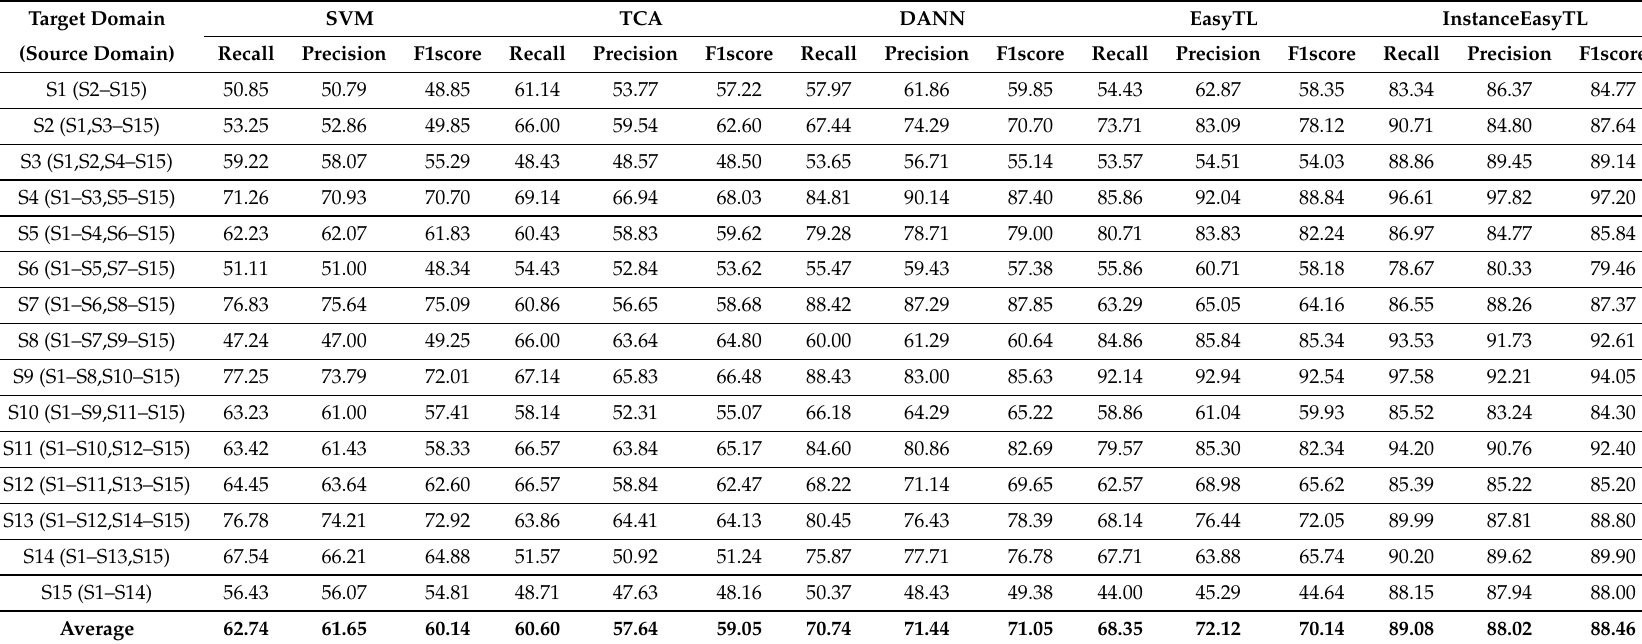
Table 2. Recall, Precision and F1score(%)